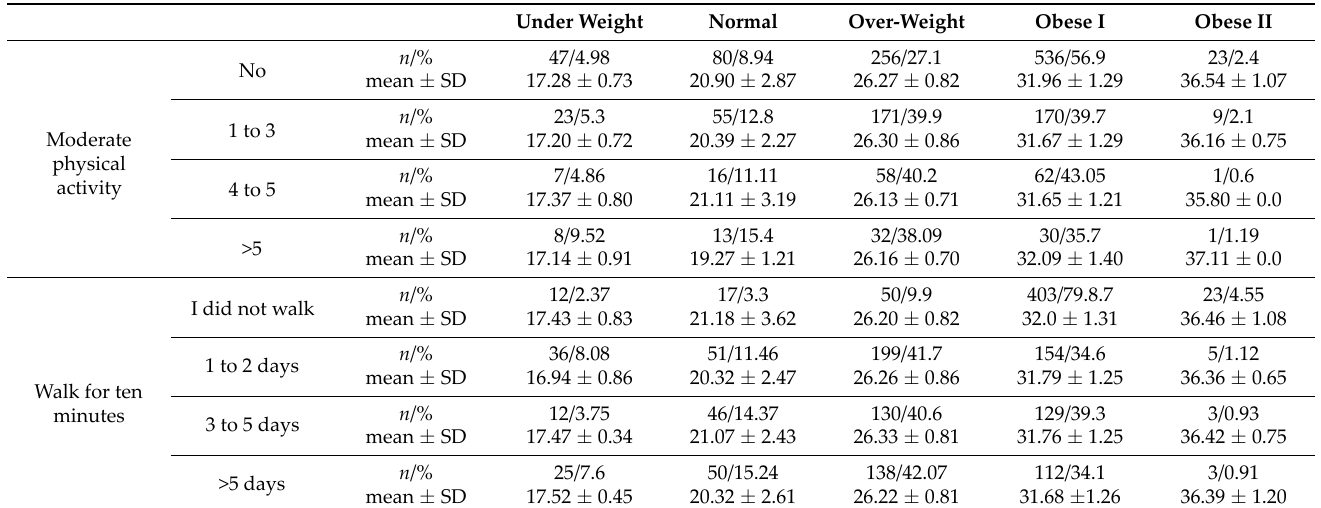
Table 6. Cont. Under Weight Normal